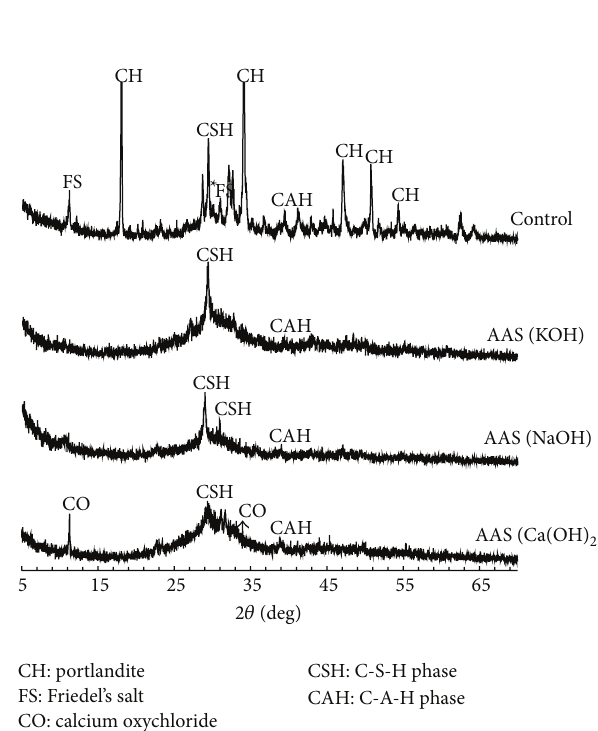
Figure 4: XRD curves for AAS paste admixed with 1.5%